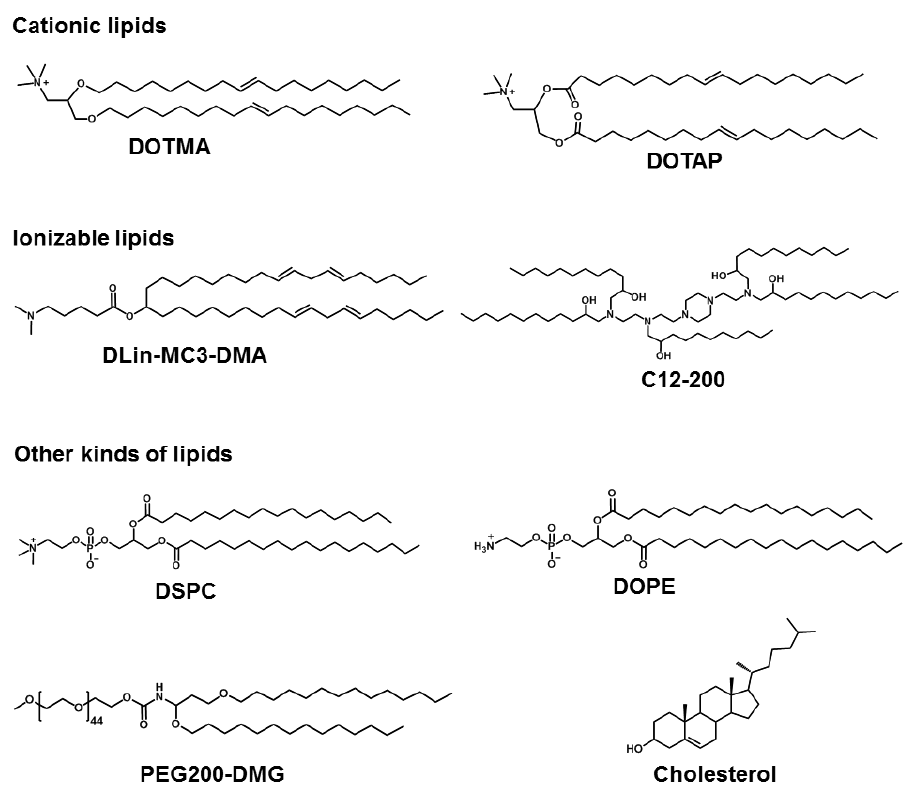
Figure 2. Representative cationic lipids, ionizable lipids, and other kinds of lipids in mRNA formulations. DLin-MC3-DMA: dilinoleylmethyl- 4-dimethylaminobutyrate; DMG: dimyristoylglycerol; DSPC: 1,2-distearoyl- sn -glycero-3-phosphocholine; PEG: polyethylene